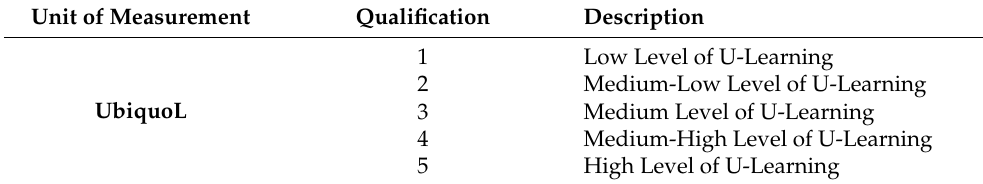
Table 2. U-CLX Model Rating—units of measurement in UbiquoL [2]. Unit of Measurement